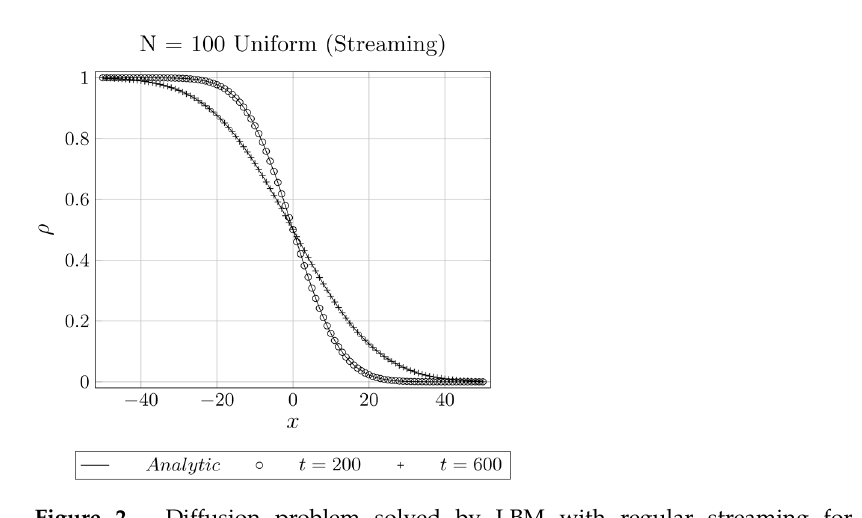
Figure 2. Diffusion problem solved by LBM with regular streaming for 100 uniformly distributed points.